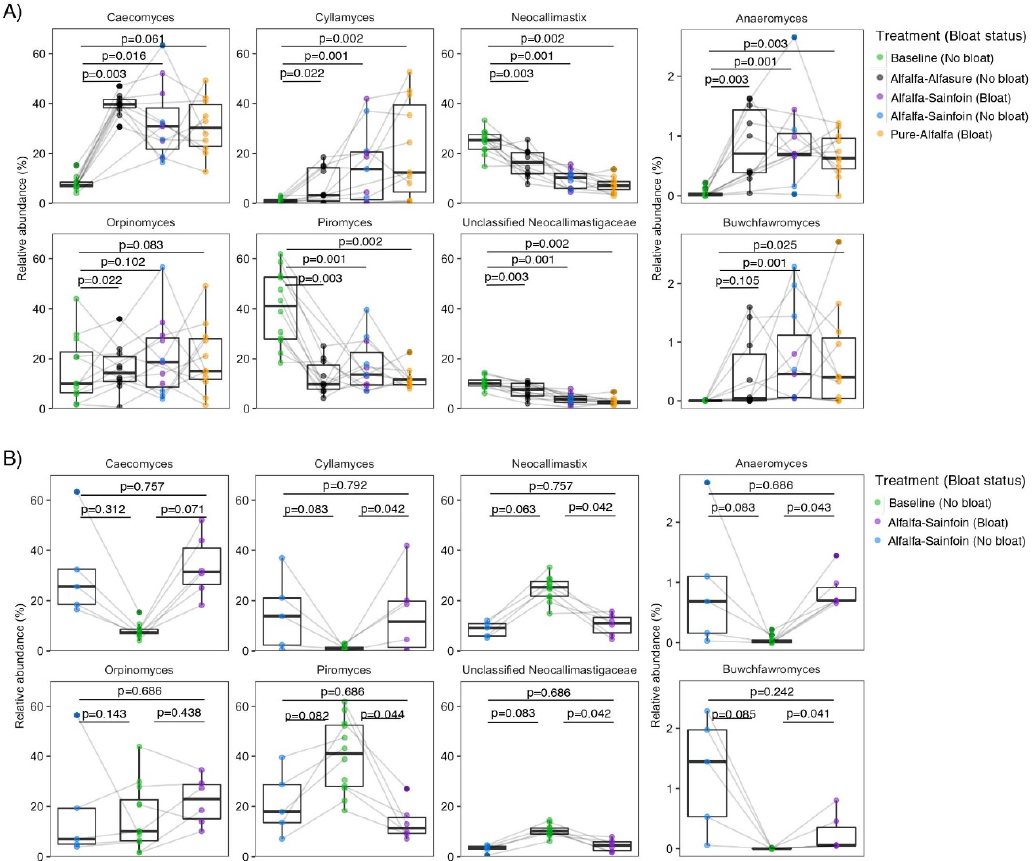
Figure 2. Pair-wise comparisons of the proportion of anaerobic rumen fungal genera ( A ) between baseline and each of the treatments, and ( B ) among steers that did and did not bloat while grazing alfalfa-sainfoin and the baseline alfalfa hay diet. Boxes show the interquartile range with a line at the median and whiskers showing minimum and maximum values. A line between two individual dots indicates the same steer in di ff erent groups. Comparisons were tested using Wilcoxon signed-rank test on center log-ratio proportions. FDR corrected p -values were obtained using the Benjamini–Hochberg procedure. p -values for all possible pair-wise comparisons can be found in Supplementary File